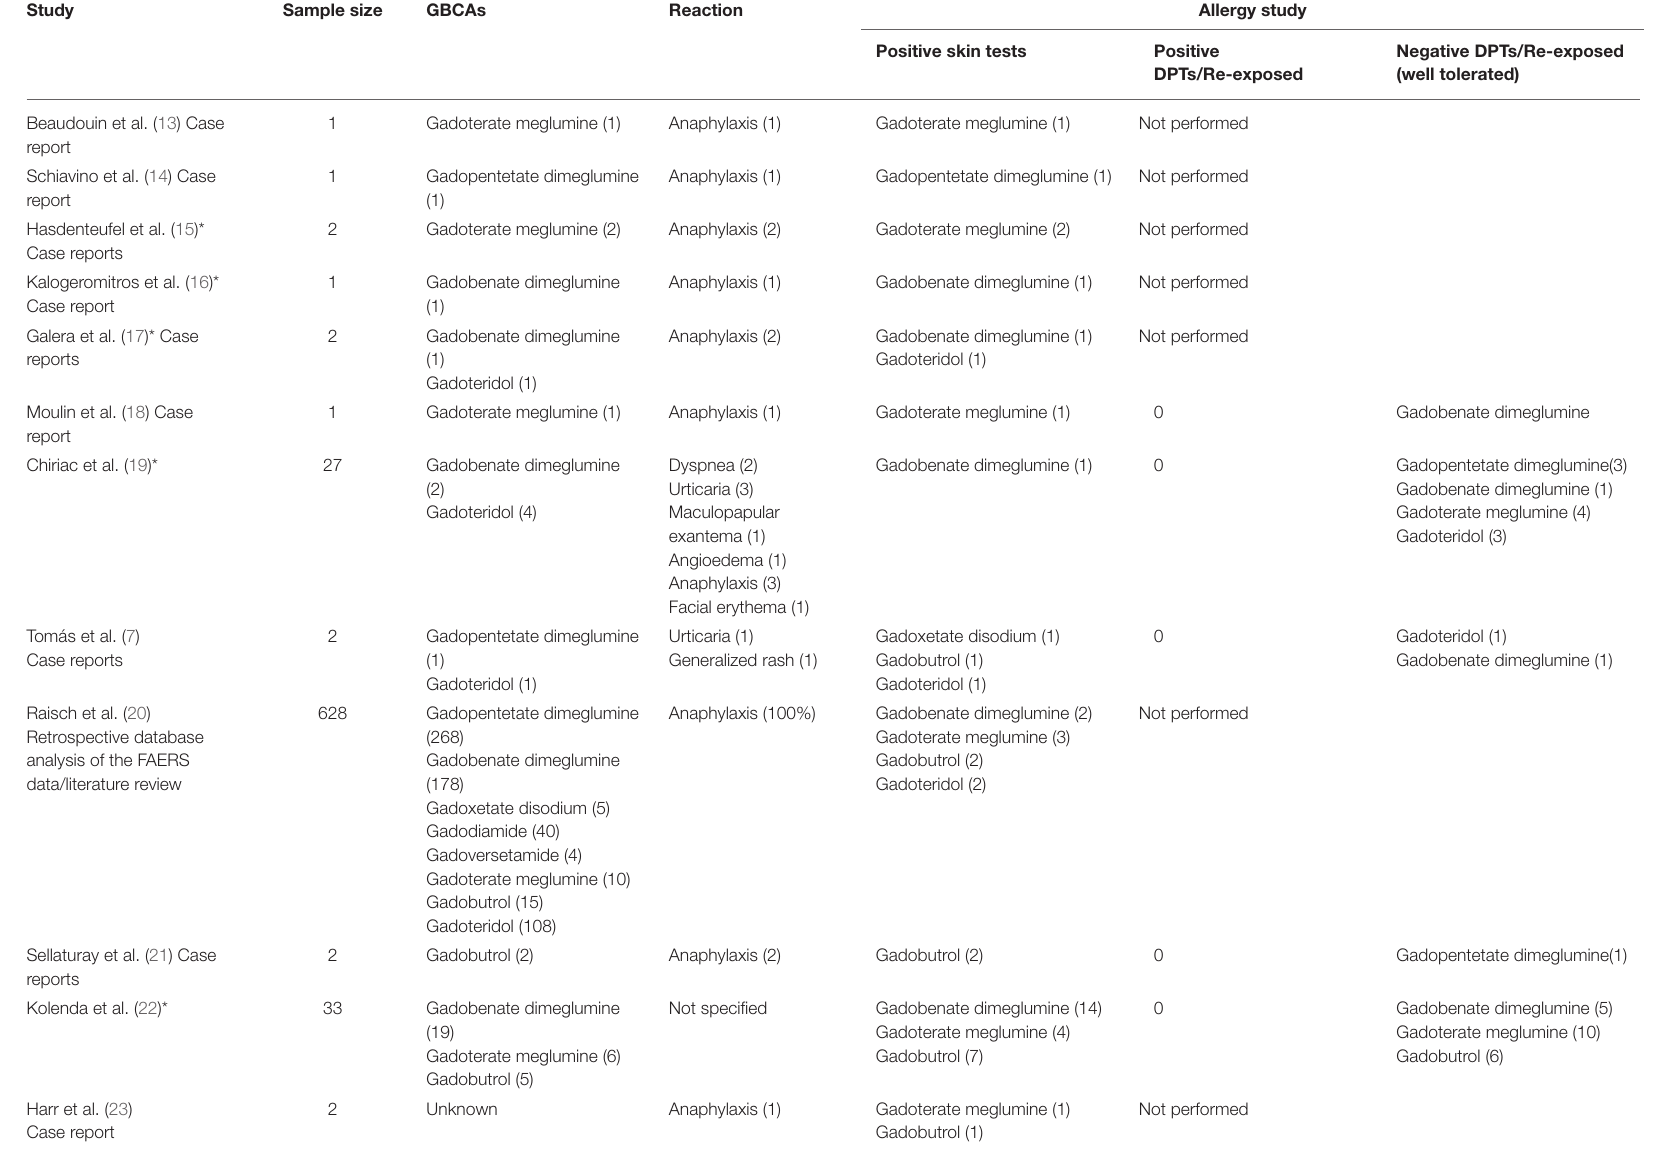
TABLE 2 | Immediate hypersensitivity reactions to